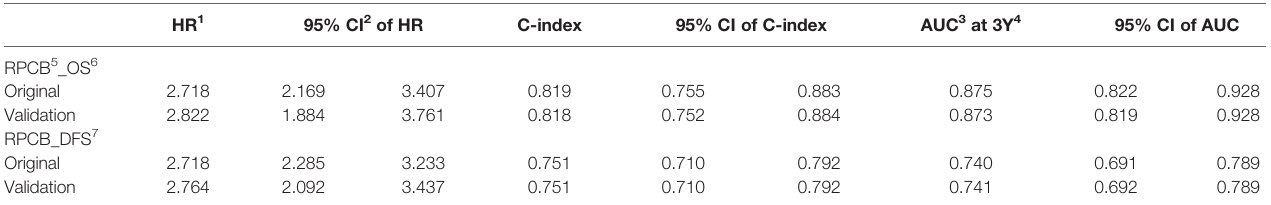
TABLE 3 | Internal validation of RPCB_OS and RPCB_DFS